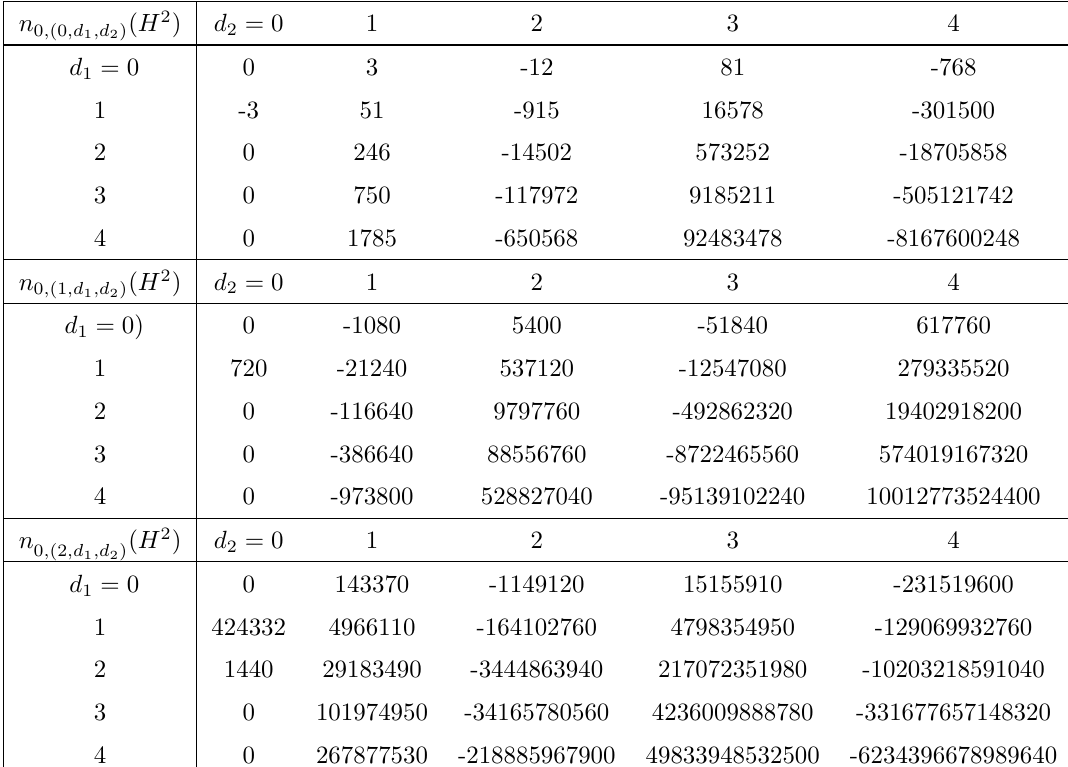
Table 6 . Genus 0 invariants associated to H 2 of M E 8 P 1 × P 2 for degree d e = 0 , 1 , 2 of the elliptic